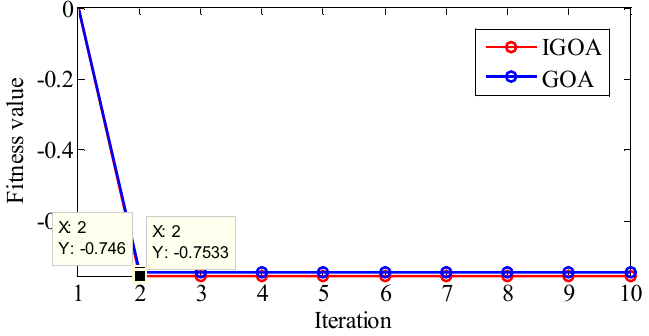
Figure 12. The optimization of TVF-EMD in the decomposition of simulation signal y ( t ) . ( ) y t is decomposed into five IMFs.